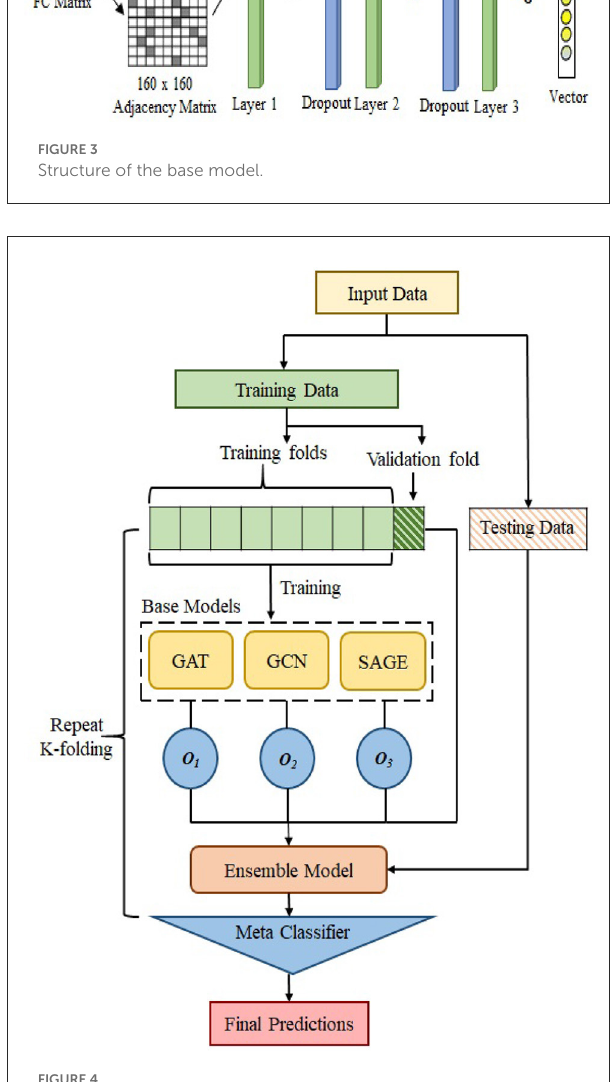
to construct the GNN-based ensemble model, the GCN, GAT, and SAGE models are used as the base models. The core operation of an ensemble model is to combine out features of base models and apply the softmax activation function to translate final scalers into predicted probabilities of the each